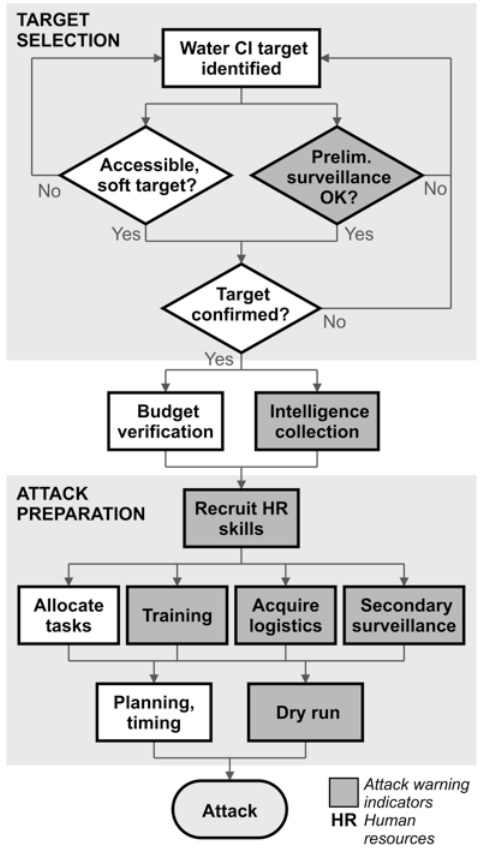
Figure 5: Terrorist attack planning process